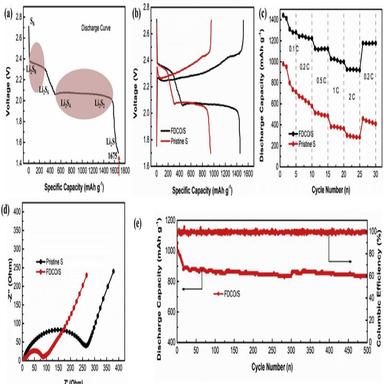
(a) The theoretical specific capacity obtained by the discharge curve. (b) The constant discharge and charge profiles of the pristine sulfur and FDCO/S composites electrode at 0.1 C. (c) Rate capability of the pristine sulfur and FDCO/S composite electrode at various current densities from 0.1 C to 2 C. (d) EIS of the pristine sulfur and FDCO/S composite electrode. (e) Long cycle performance of the FDCO/S electrode at 2 C for 500 cycles.